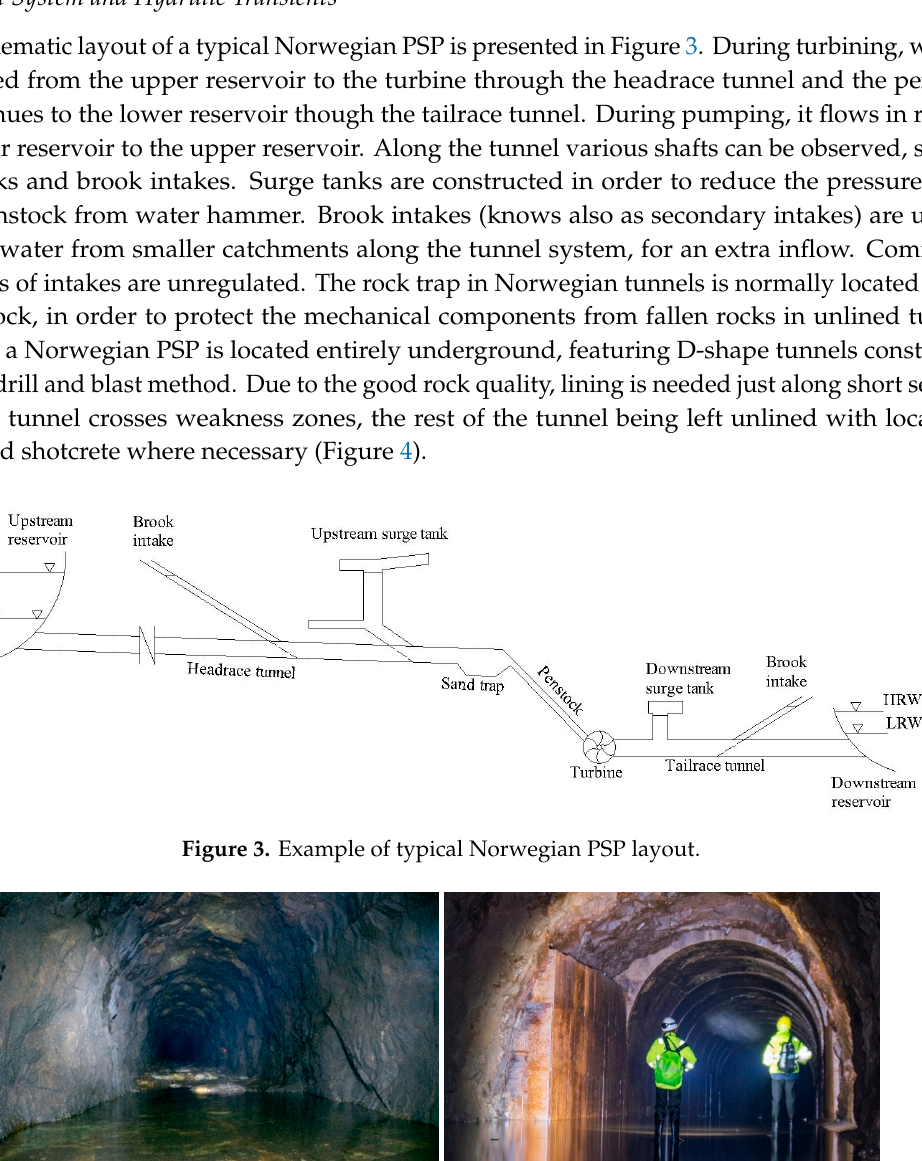
Figure 2. Cost correlation analysis for the Norwegian PSPs.